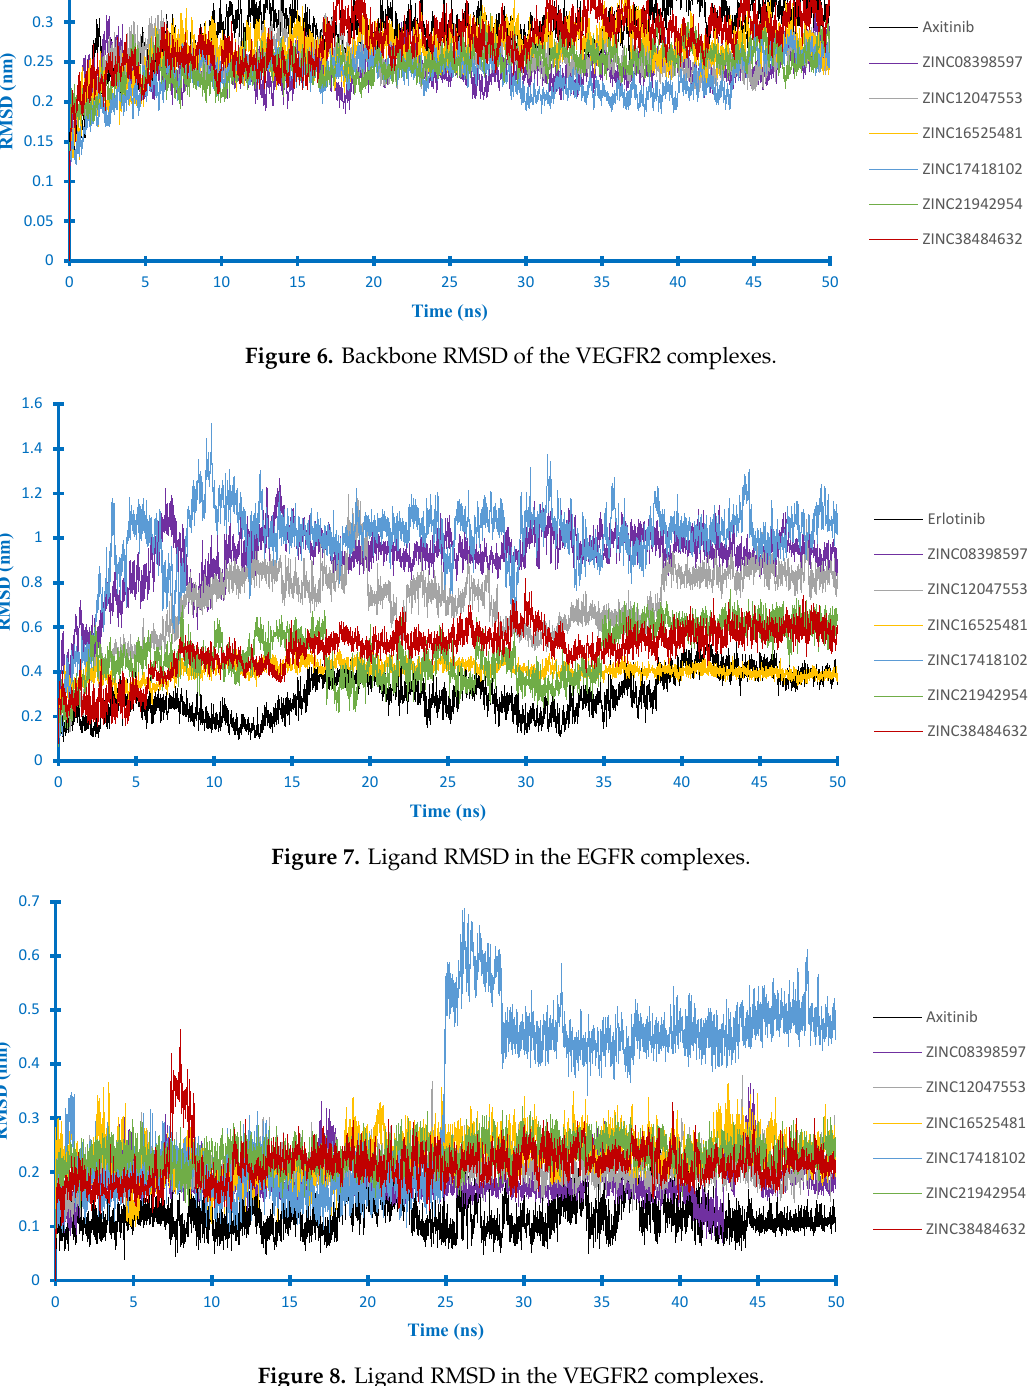
Figure 6. Backbone RMSD of the VEGFR2 complexes.